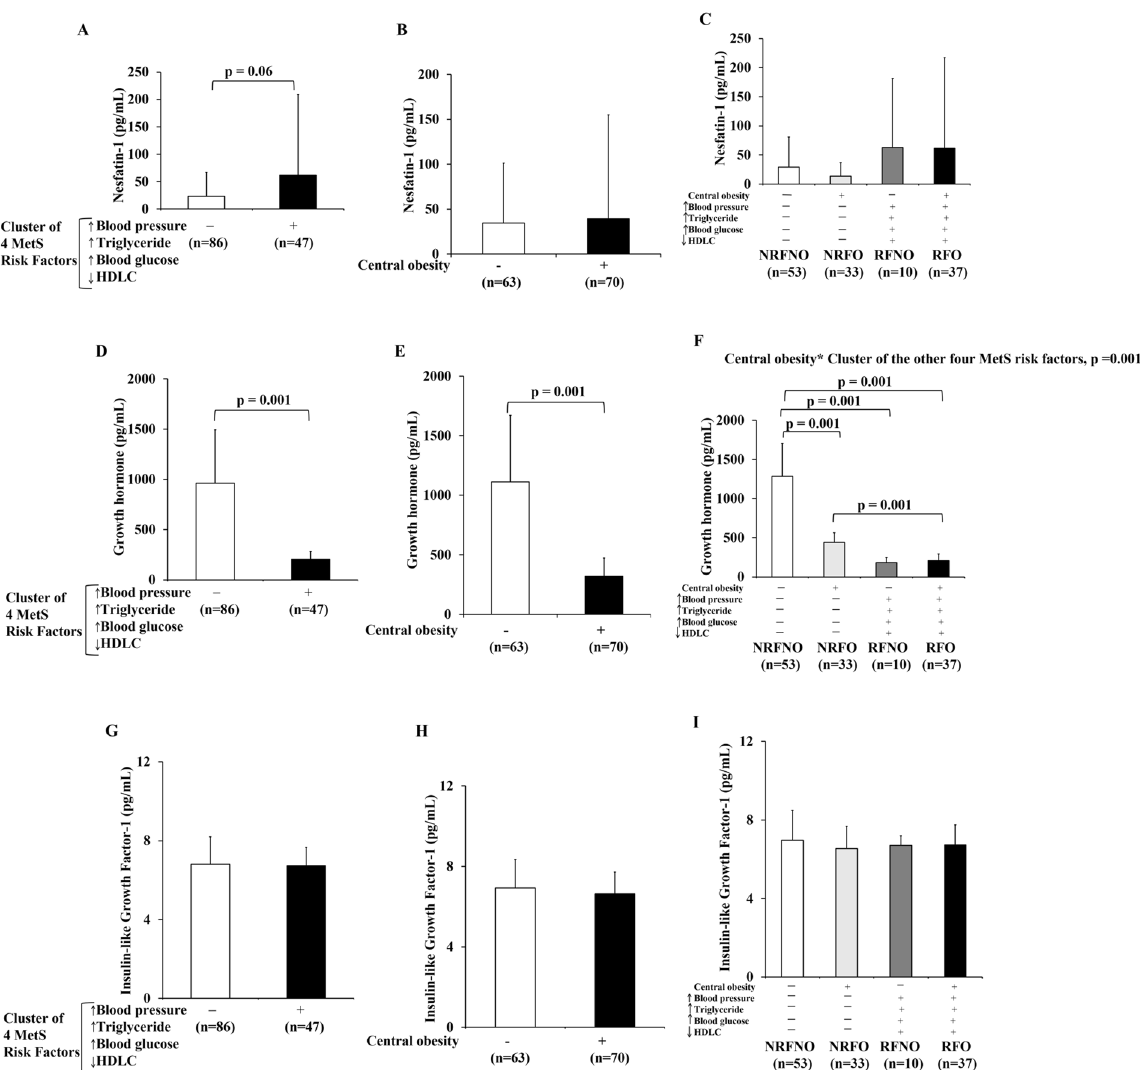
Figure 3. Levels of nesfatin-1, GH and IGF-1 in response to CO or the cluster of the other four MetS risk factors alone as well as CO in conjunction with the cluster of the other four MetS risk factors. Nesfatin-1 level of subjects with/without the cluster of four MetS risk factors regardless of the status of CO (RFNO and RFO vs NRFNO and NRFO) ( A ). Nesfatin-1 level of subjects with/without CO regardless of the status of the cluster of four MetS risk factors (NRFNO and RFNO vs NRFO and RFO) ( B ). Comparison of Nesfatin-1 level among subjects with no MetS risk factors (NRFNO), central obese only (NRFO), the cluster of the other MetS risk factors other than central obese (RFNO), and all MetS risk factors (RFO) ( C ). Growth hormone level of subjects with/without the cluster of four MetS risk factors regardless of the status of CO (RFNO and RFO vs NRFNO and NRFO) ( D ). Growth hormone level of subjects with/without CO regardless of the status of the cluster of four MetS risk factors (NRFNO and RFNO vs NRFO and RFO) ( E ). Comparison of growth hormone level among subjects with no MetS risk factors (NRFNO), central obese only (NRFO), the cluster of the other MetS risk factors other than central obese (RFNO), and all MetS risk factors (RFO) ( F ). Insulin-like growth factor-1 level of subjects with/without the cluster of four MetS risk factors regardless of the status of CO (RFNO and RFO vs NRFNO and NRFO) ( G ). Insulin-like growth factor-1 level of subjects with/without CO regardless of the status of the cluster of four MetS risk factors (NRFNO and RFNO vs NRFO and RFO) ( H ). Comparison of Insulin-like growth factor-1 level among subjects with no MetS risk factors (NRFNO), central obese only (NRFO), the cluster of the other MetS risk factors other than central obese (RFNO), and all MetS risk factors (RFO) ( I